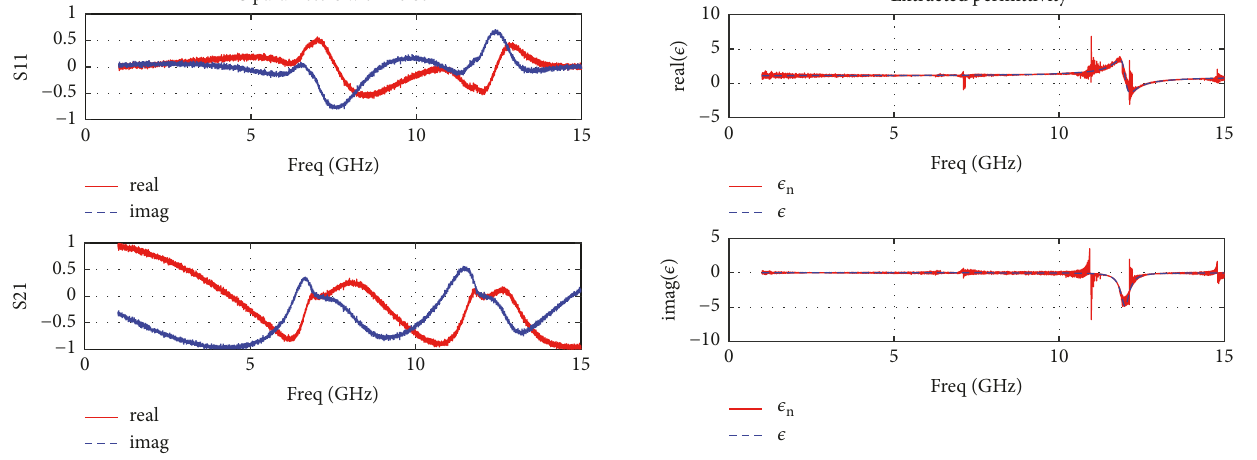
Figure 2: The extracted permittivity from the noised S11 and S21 data.